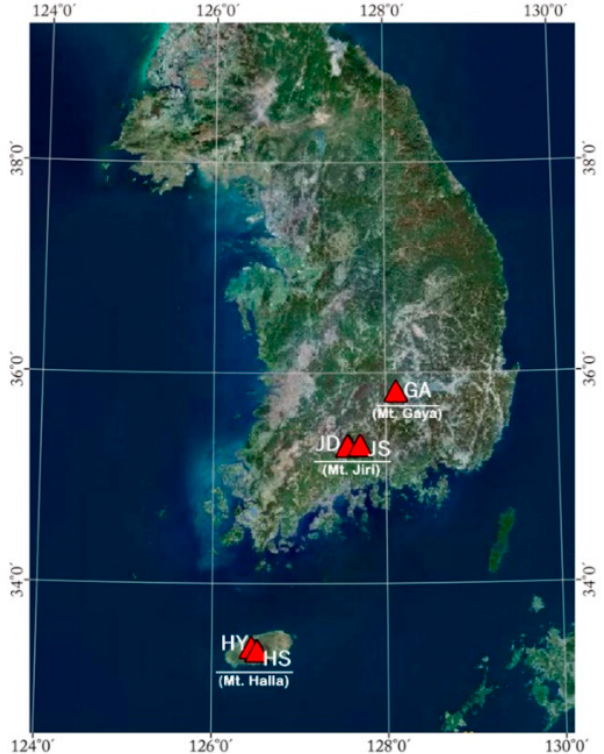
Figure 1. The distribution of the study sites located in the southern part of the Korean Peninsula. GA: Mt. Gaya; JD: Dweajiryeong of Mt. Jiri; JS: Sesuck of Mt. Jiri; HY: Youngsil of Mt. Halla; HS: southern slope of Mt. Halla.